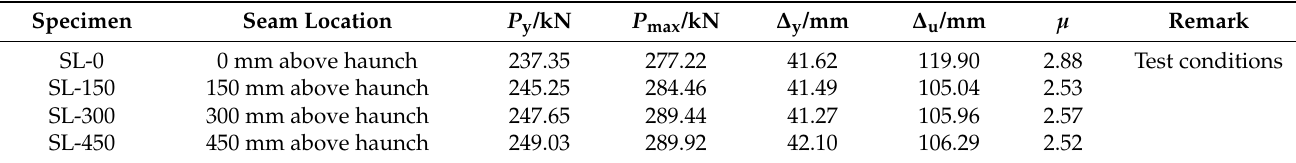
Table 3. Analysis parameters and calculation results of seam location.